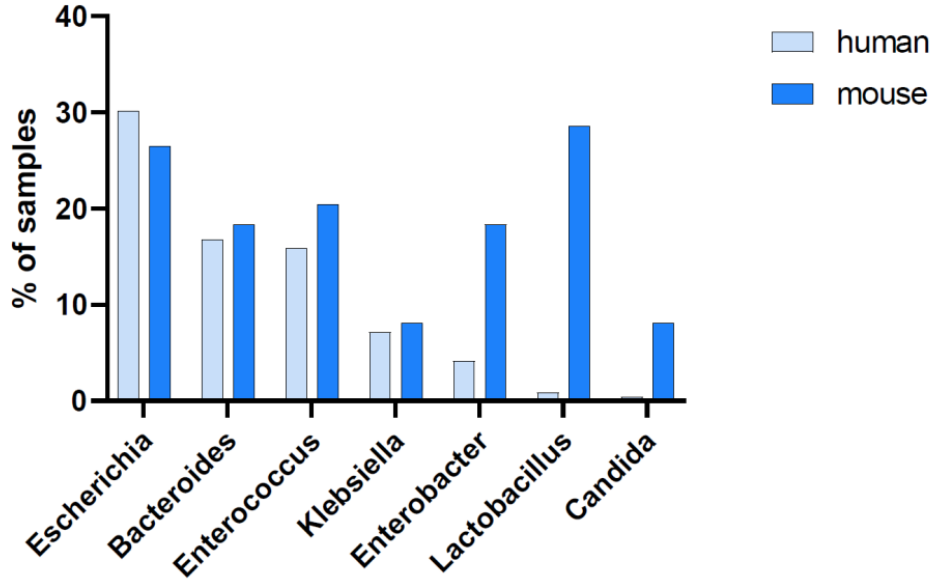
Figure 6. Abundance of the most prominent genera in the blood. Blood samples collected from septic humans ( n = 239 samples of 48 individuals at different time points) and mice ( n = 49 terminal blood samples of 49 individuals). The seven most prominent genera found in humans and mice are shown; their abundance is indicated by the percentage of blood samples showing >10 normalized sequencing reads for the respective genus out of all available blood samples.